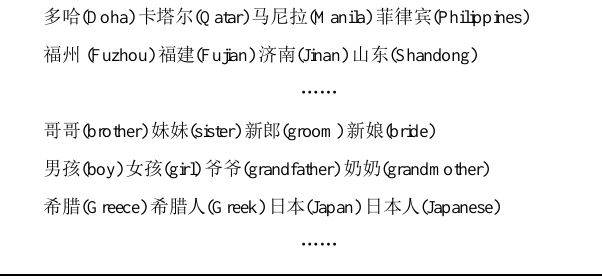
Figure 3. Examples of our results from GloVe-100-10